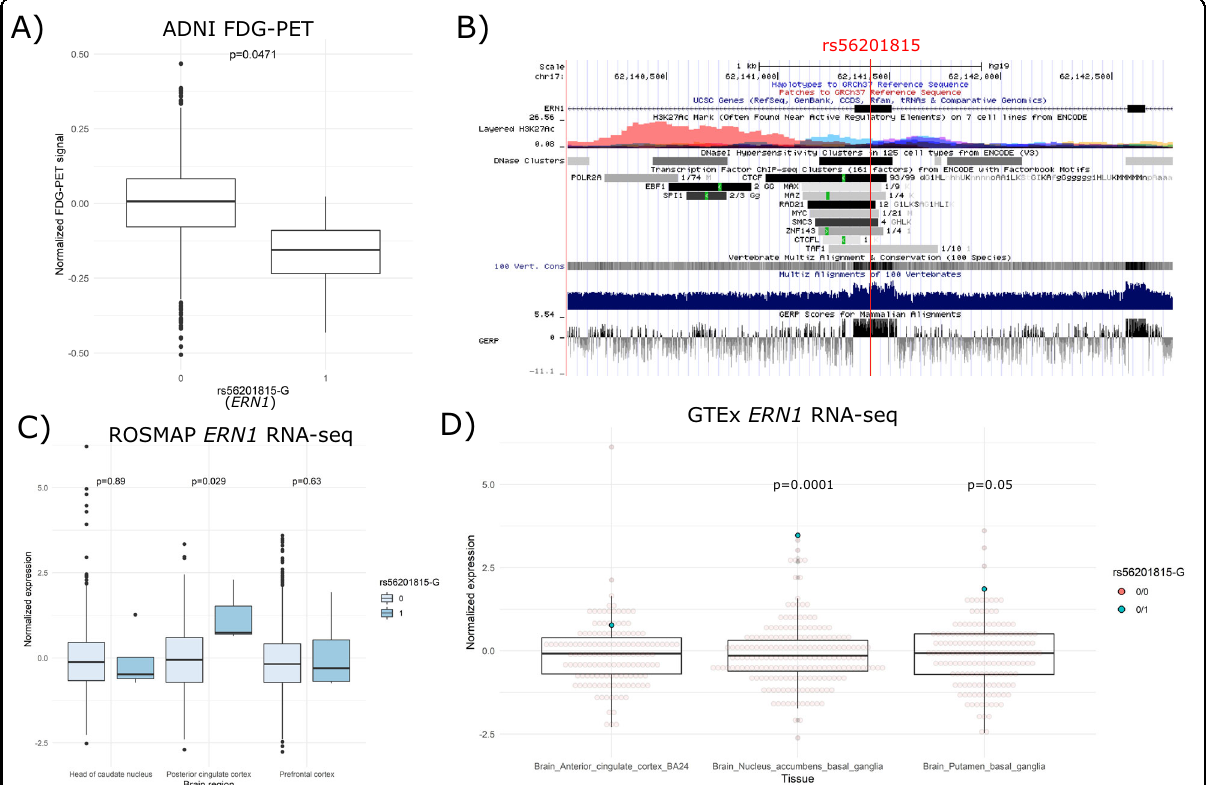
Fig. 3 Biological effects of the ERN1 variant rs56201815. A Normalized longitudinal FDG-PET measurements between the rs56201815-G carriers and non-carriers in ADNI. The p -value was calculated using a linear mixed-effects model in which individual-level random effects and three covariates (age at the measurement, sex, and diagnosis) were adjusted. B Annotation of histone modi fi cations, transcriptional factor binding, and evolutionary conservation in the genomic region of rs56201815. C Normalized expression of ERN1 between the rs56201815-G carriers and non-carriers in three brain tissues in the cerebrum (dorsolateral PFC, PCC, and anterior caudate nucleus) from a ROSMAP RNA-seq sample. D Normalized expression of ERN1 between the rs56201815-G carriers and non-carriers in the anterior cingulate cortex, nucleus accumbens, and putamen from GTEx RNA-seq